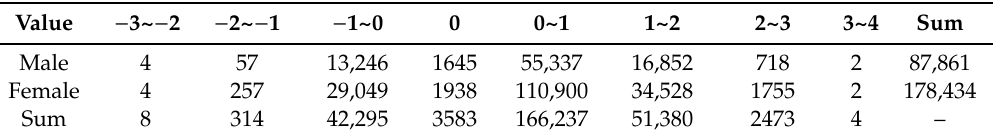
Table 2. Values of mood points.